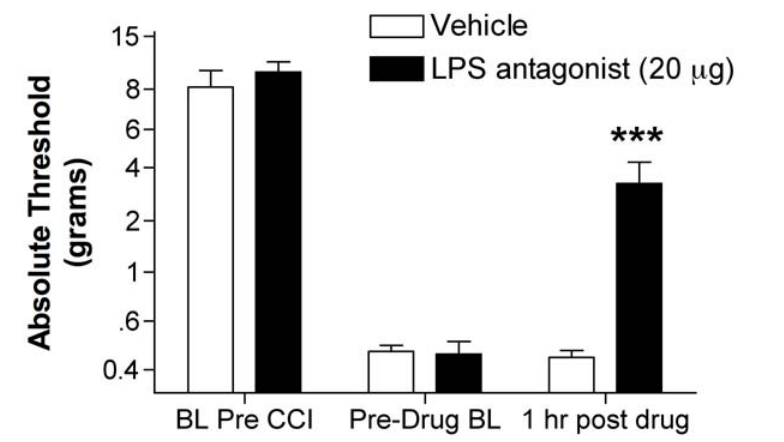
FIGURE 2. Chronic constriction injury (CCI)–induced allodynia is reversed by acute blockade of TLR4 . Intrathecal delivery of 20 μ g of LPS antagonist (LPS from msbB mutant E. coli ; Invivogen, San Diego, CA) acutely reverses allodynia induced by CCI of the sciatic nerve (n = 4 per group). This LPS antagonist is a mutant form of LPS that lacks the myristoyl fatty acid moiety of the lipid A and displays 1,000- to 10,000-fold reduction in activation of NF- κ B and acts as an antagonist of TLR4[25]. BL (baseline) pre-CCI Von Frey testing of thresholds occurred the day of CCI surgery of the left sciatic nerve. Allodynia developed across the following 10 days with maximal allodynia achieved and maintained from this point for a further 21 days. Predrug BL thresholds were assessed the morning of the test day. Acute intrathecal delivery via the lumbar approach of vehicle and drug was conducted under brief isoflurane anesthesia. Von Frey testing was conducted 1 h postdrug. All testing was conducted blinded to treatment group by two separate